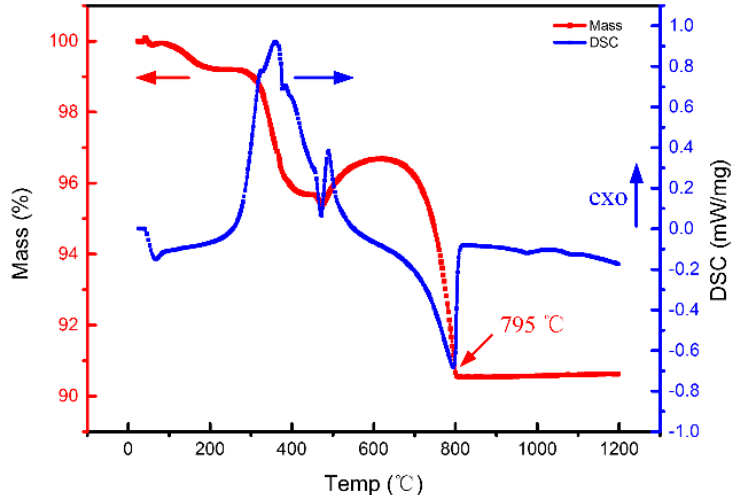
Figure 6. TD-DSC of green body of CaO-based ceramic mould.